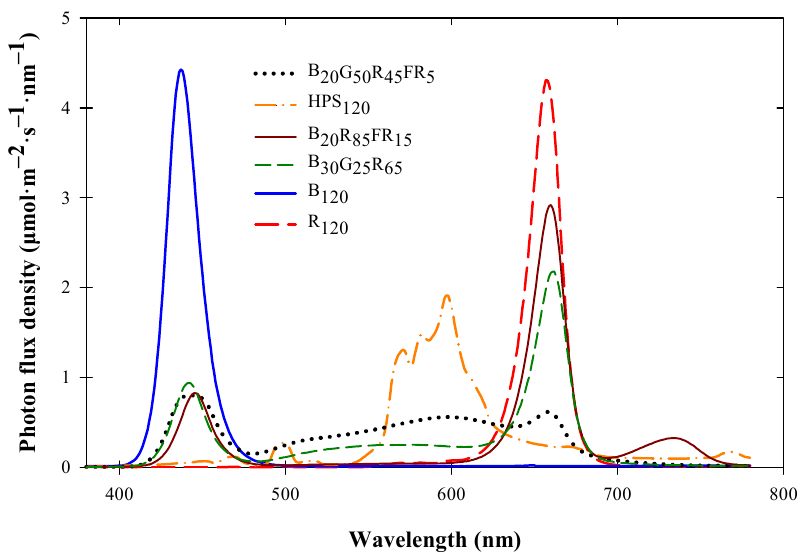
Figure 1. Emission spectra of supplemental lighting (SL) fixtures utilized throughout the study. SL treatments consisted of either 460 W high-pressure sodium fixtures (HPS 120 ; LR48877; P.L. Light Systems, Beamsville, ON, Canada), 631 W light-emitting diode (LED) fixtures (B 20 G 50 R 45 FR 5 ; VYPR 2p; Fluence, Austin, TX, USA), 325 W LED fixtures (B 20 R 85 FR 15 ; LumiGrow Pro 325; LumiGrow, Emeryville, CA, USA), 600 W LED fixtures (B 30 G 25 R 65 ; LX601G, Heliospectra, Göteborg, Sweden), a combination of 72 W LED fixtures (B 120 ; HortiLED MULTI, P.L. Light Systems) and 625 W LED fixtures (R 120 ; LumiGrow Pro 650E, LumiGrow), or 625 W LED fixtures (LumiGrow Pro 650E; LumiGrow).